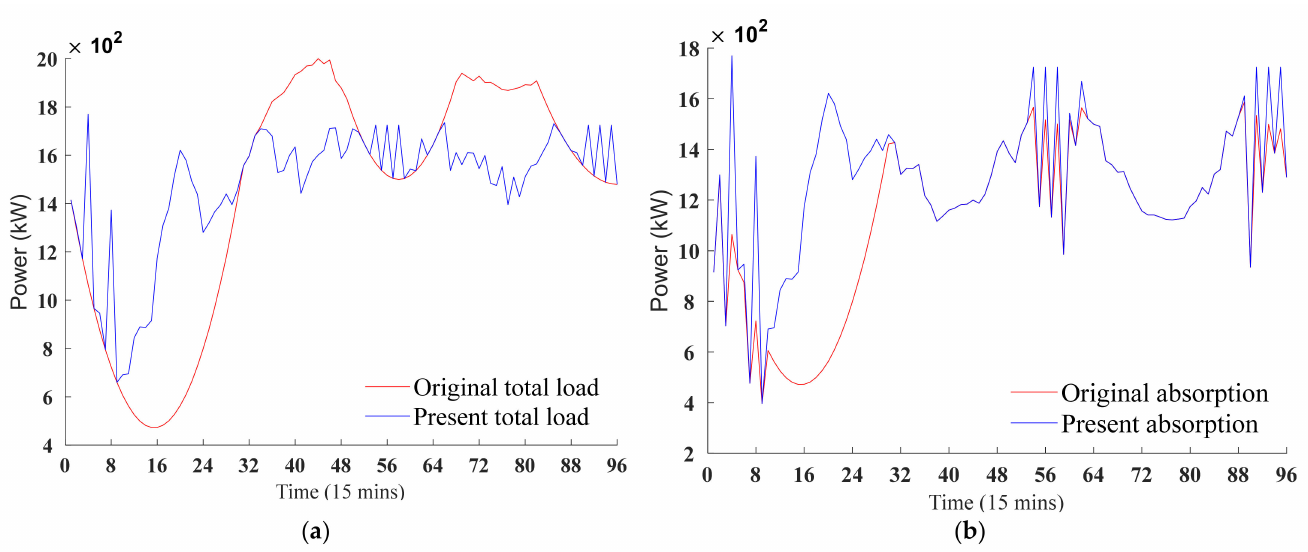
Figure 6. The change of the total load curve and the absorption of renewable sources inside the microgrid. ( a ) The total load curve; ( b ) The absorption of renewable sources inside the